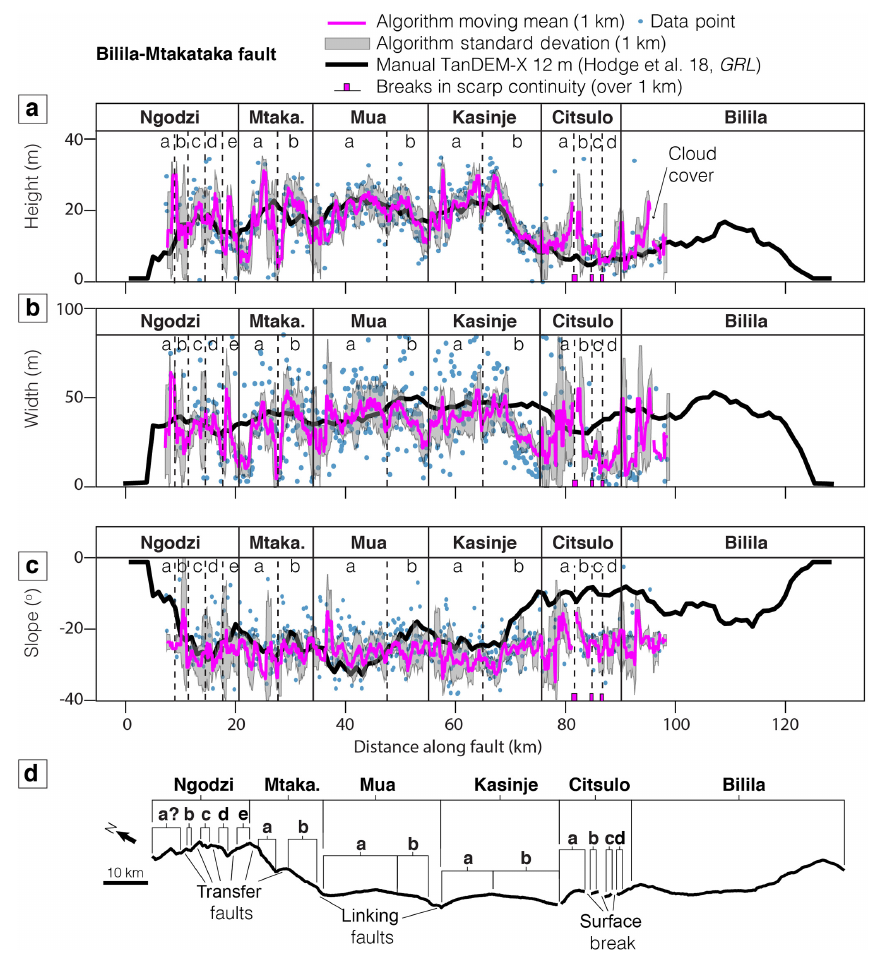
Figure 10. Panels (a) – (c) show the height, width and slope profiles for the Bilila–Mtakataka fault scarp using the Pleiades DEM, indicating the major segments proposed in Hodge et al. (2018b) (Ngodzi, Mtakataka, etc.) and newly identified secondary segments (a, b, etc.) from this study. (d) A map view showing fault structural segmentation, breaks in scarp and the location of inferred linkage structures. Table 2. The best-performing algorithm parameters for the Thyolo, Muona and Malombe faults based on a misfit analysis using the TanDEM- X DEM: Lowess (LW) or Savitzky–Golay